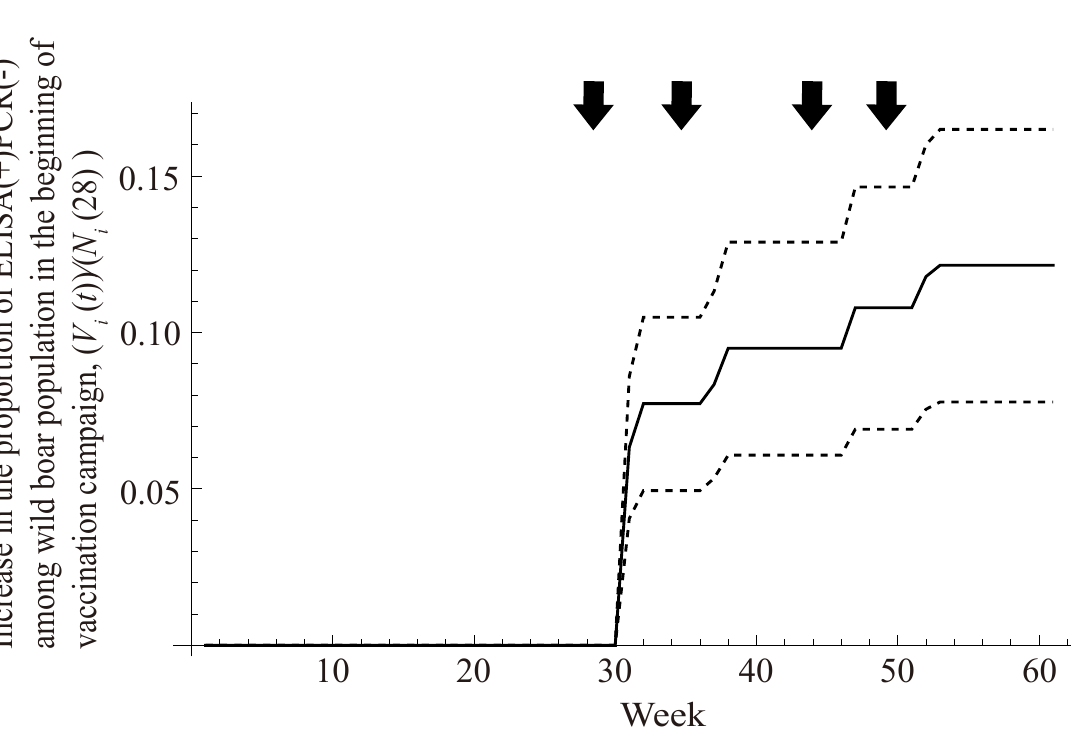
Fig 3. Change in the proportion of immunised wild boar by the bait vaccination among the total wild boar population at the beginning of vaccination campaign, ( V i ( t ))/( N i (28)). Mean estimated increment of the proportion of ELISA(+) PCR(-) is demonstrated by the solid line. The 95% confidence intervals are shown by dashed lines. The bait vaccination was implemented in the weeks 28–29, weeks 34–35, week 44, and weeks 49–50. Arrows denote the timing of vaccine